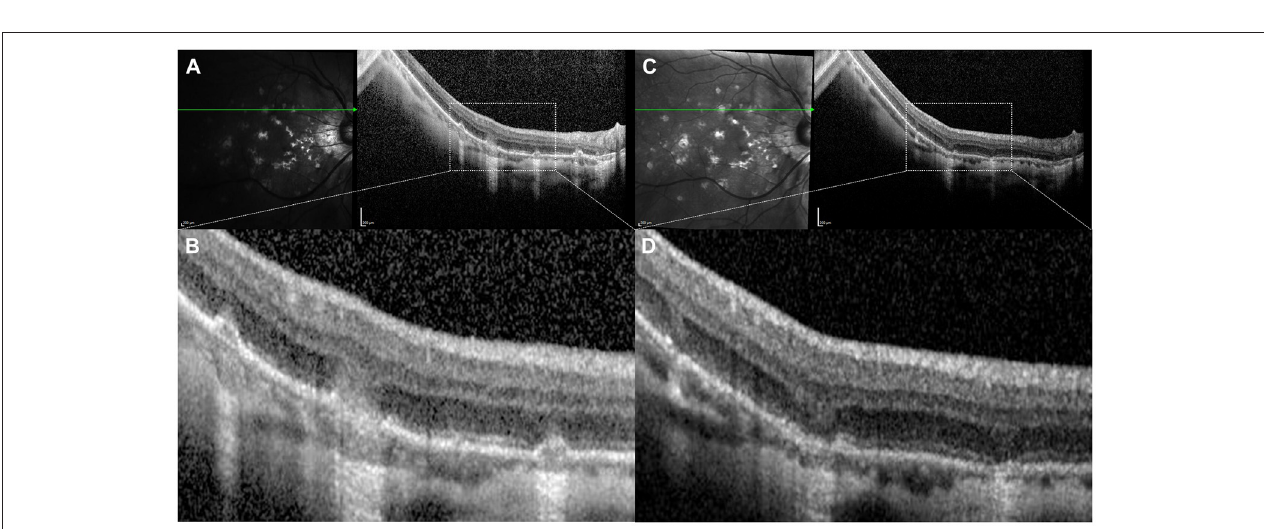
FIGURE 10 | Optical coherence tomography (OCT) scans in a 49-year-old male myopic patient with recurrent inflammation due to multifocal choroidits. (A) OCT scan coincident with acute symptoms showing multifocal areas of disruption of the retinal pigment epithelium (RPE) layer leading to choroidal hypertransmission. (B) Detail of the previous image revealing structural lesions consisting on RPE disruption with secondary choroidal hypertransmision, associated with overlying external limiting membrane (ELM) and photoreceptors ellipsoid zone disruption, and hyperreflective subretinal material. (C) OCT scan performed after 3 weeks of oral steroids treatment showing decrease in choroidal thickness, regression of hyperreflective material and suboptimal restoration of the RPE layer. (D) Detail of the previous image revealing significant decrease in choroidal thickness compared with the baseline image (B) and decrease in choroidal hypertransmission due to suboptimal restoration of the RPE layer. There is complete regression of the subretinal hyperreflective material and persistence of MLE and photoreceptors ellipsoid zone